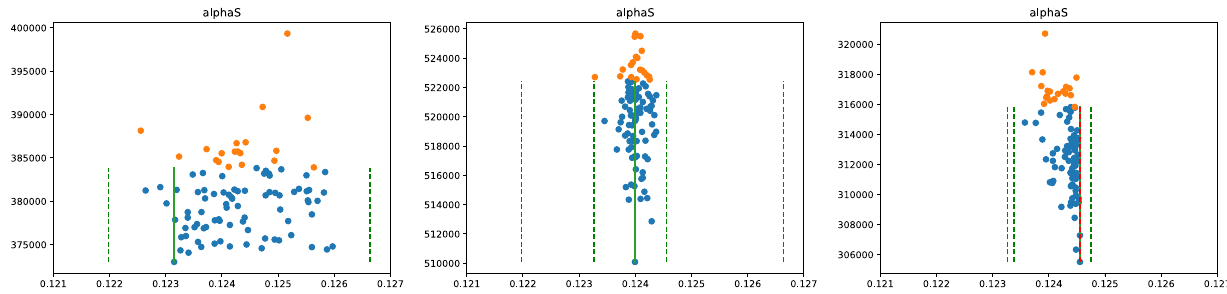
(orange points) are neglected. The lowest G.o.F. value (solid green line) defines the current best tune value that is used as starting value for next tune-steps and iterations. The G.o.F. values are calculated including the weights for the observables given by the algorithm. Hence, for the best fit and the range only the relative values are important and G.o.F. values between iterations are not comparable